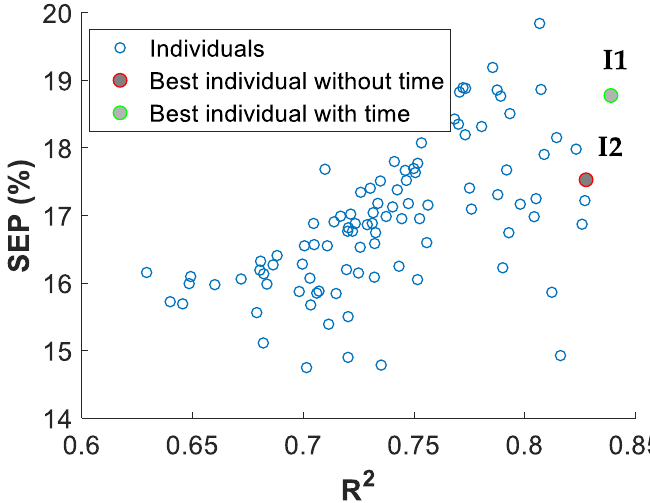
Figure 5. Pareto front for the last generation.